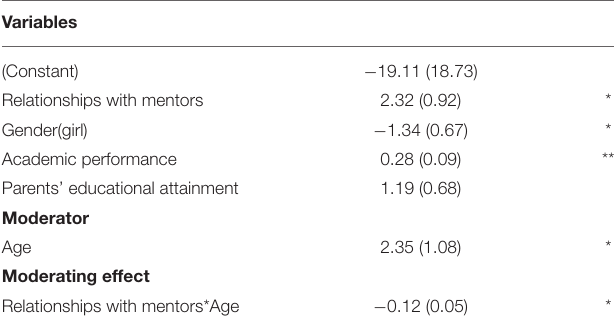
TABLE 2 | Moderating effects of age on self-efficacy using SPSS